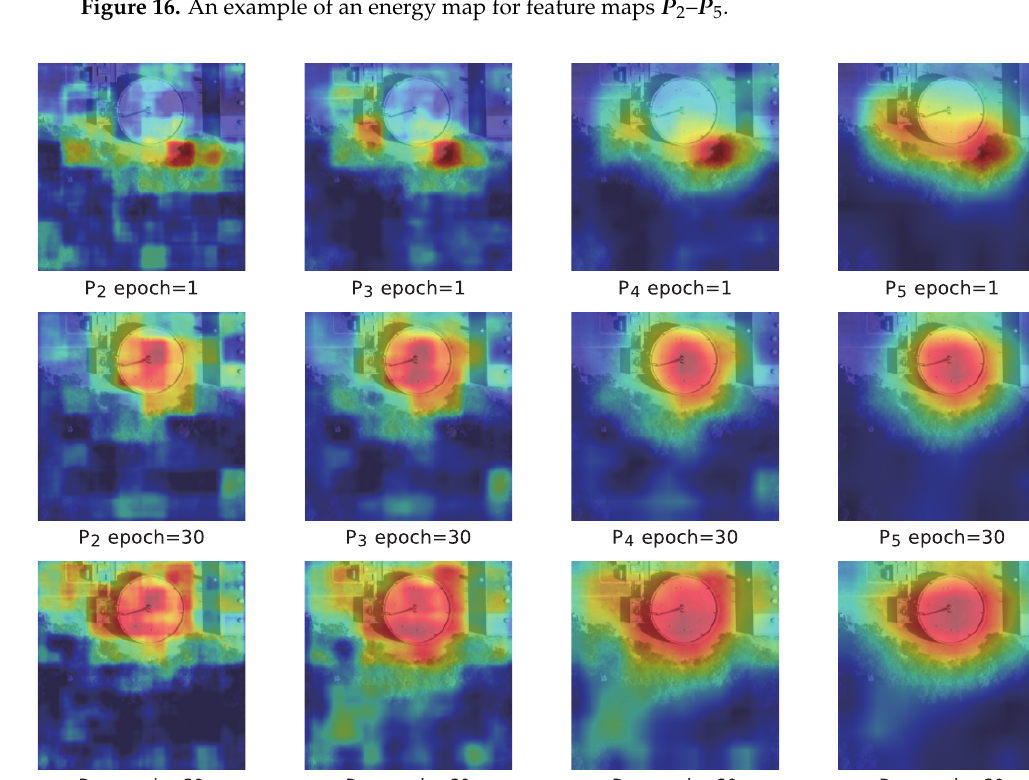
Figure 17. An example of an energy map for feature maps P 2 – P 5